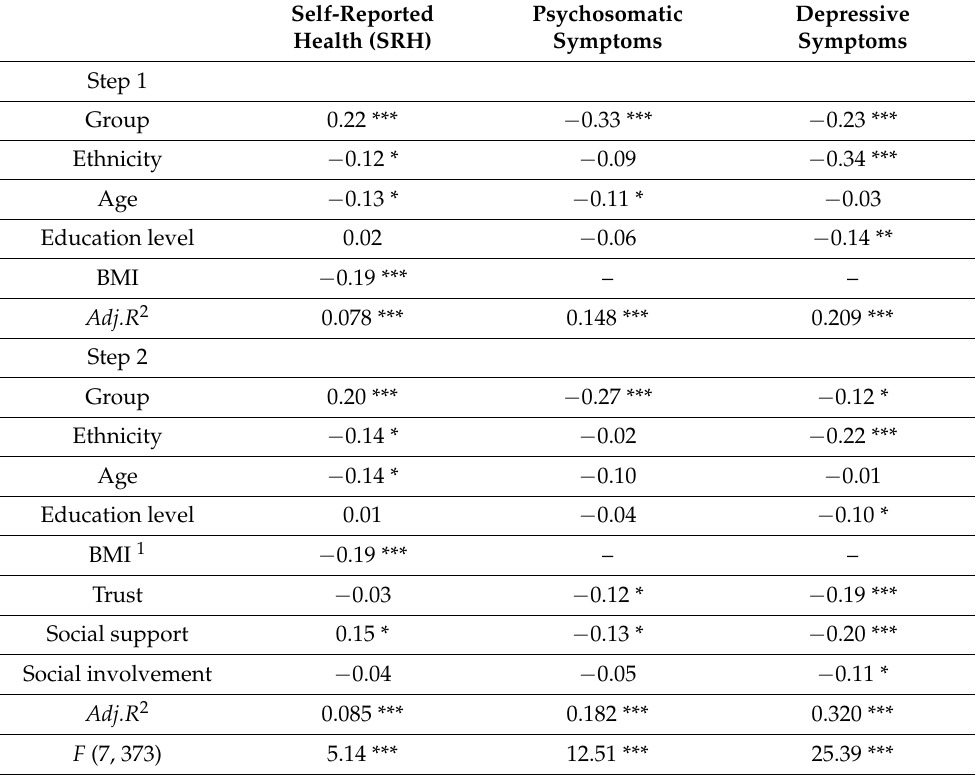
Table 4. Multiple regression coefficients ( β ) for self-reported health, psychosomatic symptoms, and depressive symptoms, with background variables and social capital (n = 381). Self-Reported Psychosomatic Depressive Health (SRH) Symptoms Symptoms Step 1 Group 0.22